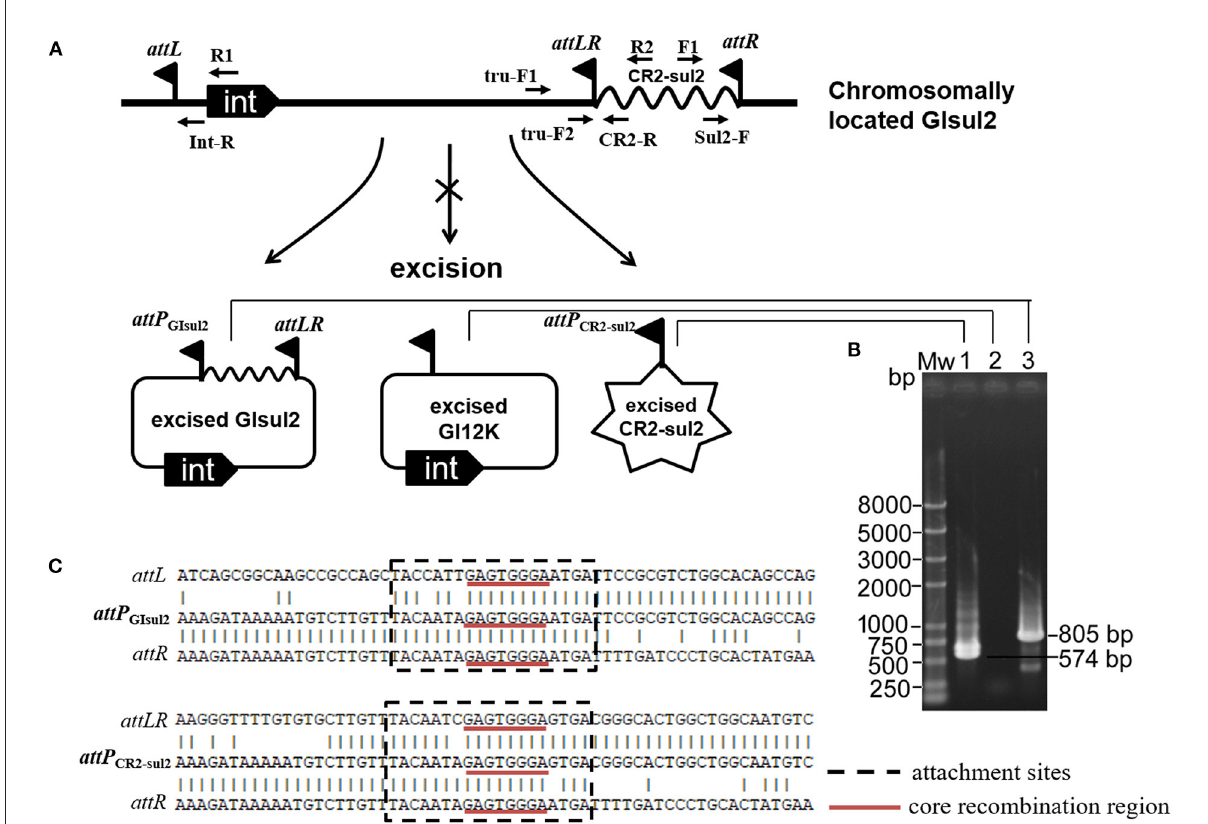
FIGURE2 Excision of GI sul2 and of CR2 -sul2 unit from the chromosome of S. flexneri 51575. (A) The predicted circular intermediates resulting from recombination between the three att sites of GI sul2 . The crossed arrow indicates that the event could not be observed. Solid flags denote the various att sites. (B) Nested PCR assays for the detection of the three potential circular intermediates: Mw, M5 DL2000 plus DNA Marker (Mei5 Biotechnology, Beijing); lane 1, CR2 -sul2 circular intermediate; lane 2, GI12K circular intermediate; lane 3, GI sul2 circular intermediate. (C) Alignment of the sequenced junctions resulting from the circularization of GI sul2 ( attP GI sul2 ) and of CR2 -sul2 unit ( attP CR2 − sul2 ) with their corresponding initial att